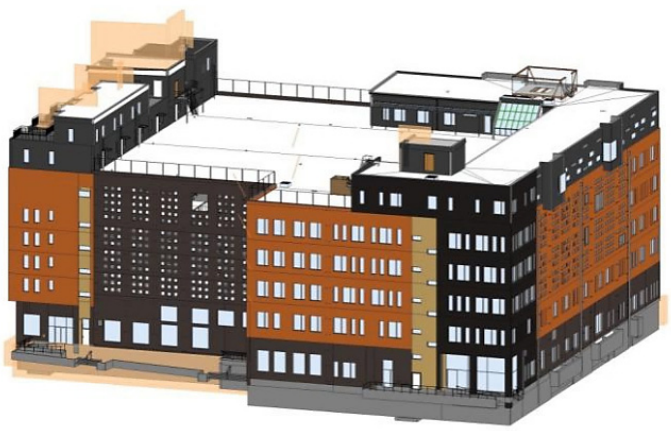
Figure 6. Industry Foundation Classes (IFC) model shown in Revit (Source: NCC Company).